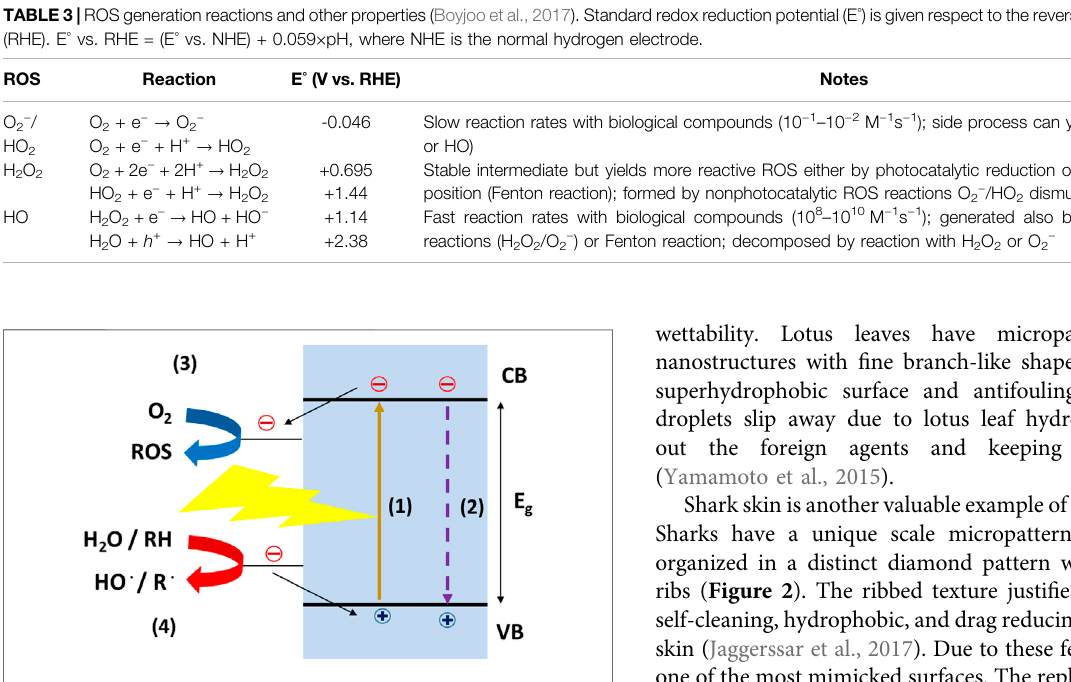
FIGURE 5 | General mechanism of